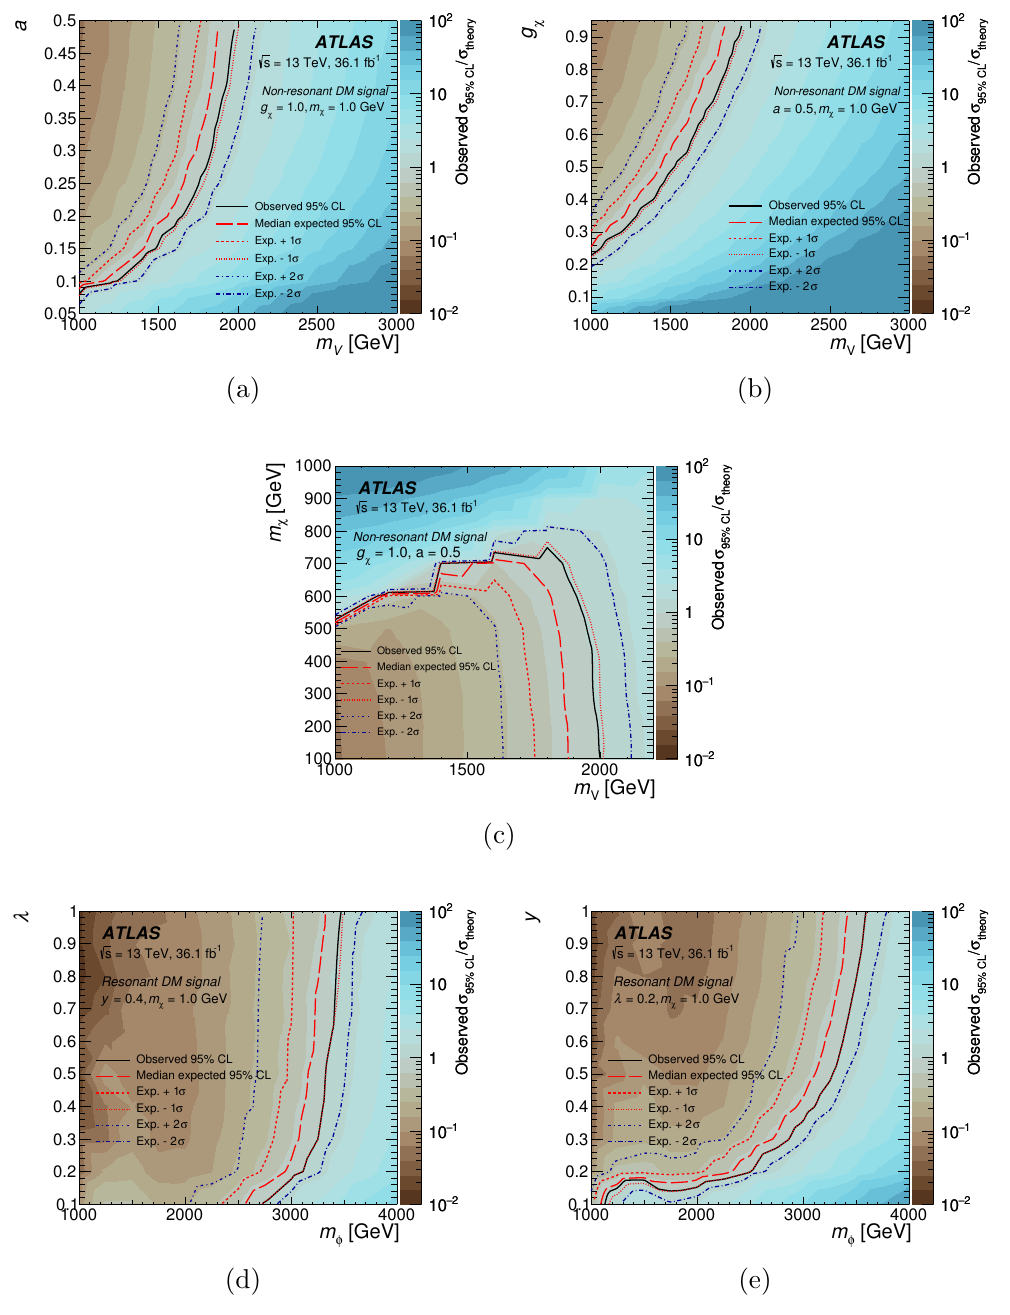
Figure 5 . The 95% CL upper limit contours on the signal strength (cid:27)=(cid:27) theory are shown for the non-resonant (NR) and resonant (R) DM production models. Non-resonant model: (a) V mass vs a ; (b) V mass vs g (cid:31) and (c) V mass vs mass of the DM candidate (cid:31) . Resonant model: (d) mass of the scalar (cid:30) vs (cid:21) ; (e) mass of the scalar (cid:30) vs y . The solid (dashed) lines correspond to the observed (median expected and corresponding 1 (cid:27) and 2 (cid:27) bands) limits for (cid:27)=(cid:27) theory = 1. The predicted (cid:6) (cid:6) cross-sections were computed with MadGraph5 aMC@NLO.